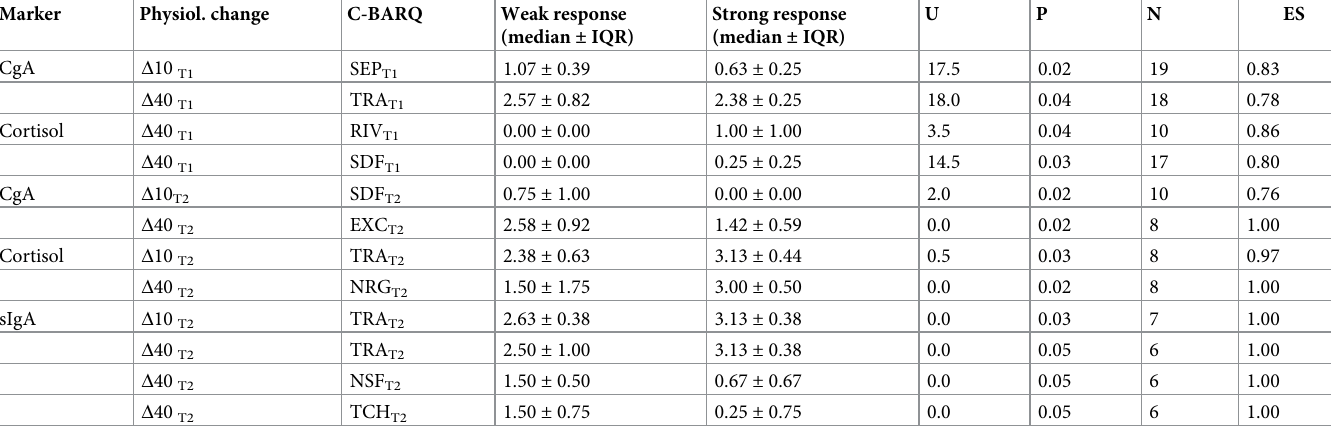
The upper panel presents data from T1 (puppy stage), the lower panel from T2 (young adult stage). “Strong response” dogs are those with the largest physiological change (above median), as expected for that marker (increase for CgA and cortisol, decrease for sIgA).